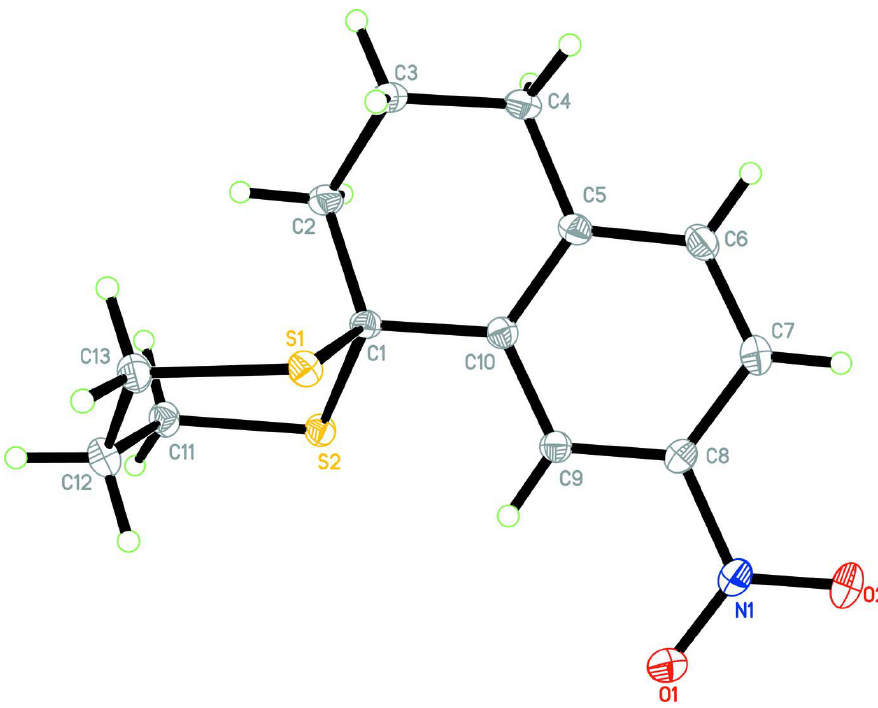
Figure 1 The molecular structure of (I), showing 50% probability displacement ellipsoids and the atomic